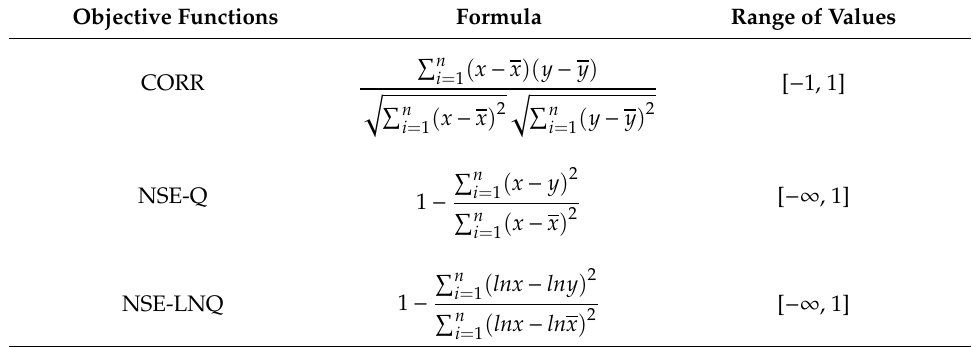
Table 3. Description of objective functions. In these formulas x , y , x and y indicate observation data, simulation data and their means,